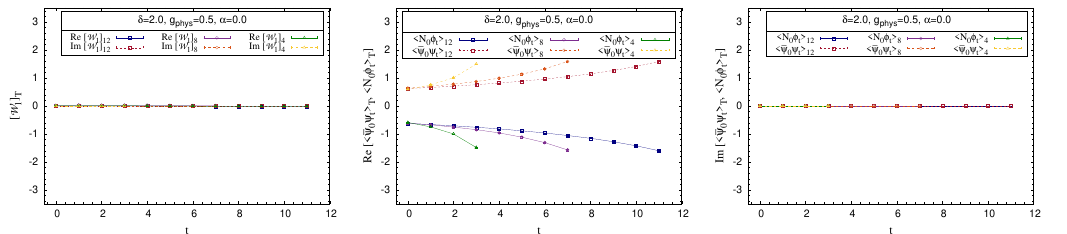
Figure 7 . The PT -symmetric model with δ = 2 . The full Ward identity (left) and real (middle) and imaginary (right) parts of bosonic and fermionic contributions to Ward identity, for lattices with T = 4 , 8 , and 12 .